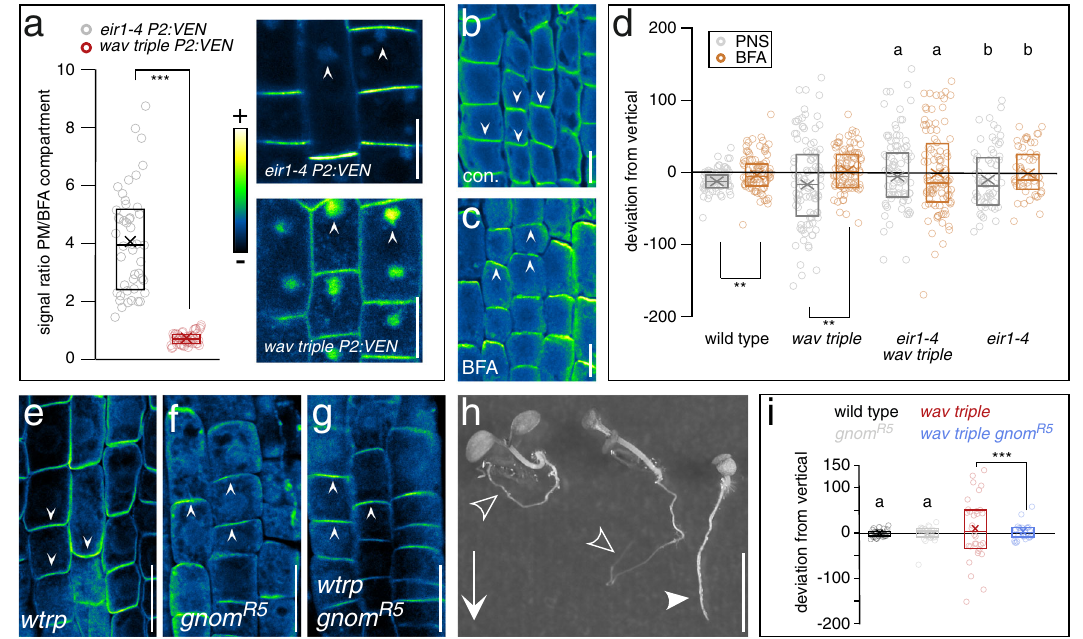
Fig. 6 | Wav triple -induced PIN2 polarity switches are mediated by BFA- sensitive cargo sorting. a PIN2::PIN2:VEN reporter signal distribution in root meristemepidermiscellsof6DAG eir1-4 ( n =47cells/7roots)and wavtriple ( n =46 cells/8roots)incubatedinpresenceof 50 μ MBFAfor90min.Arrowheadsindicate accumulation of reporter signals in BFA-induced intracellular compartments. b , c Subcellular PIN2 localization in wav triple root meristem epidermis cells in 6 DAG seedlings incubated on control plates ( ‘ con. ’ ; b ) or in presence of 50 μ M BFA ( ‘ BFA ’ ; c ) for 16h. Arrowheads indicate PIN2 polarity. d Orientation of root tips, expressed as degrees deviation from vertical of 6 DAG seedlings germinated on nutrient plates and then transferred on control nutrient plates ( n =81, wild type; n =99, wavtriple ; n =77, eir1-4wavtriple ; n =60, eir1-4 )oronplatessupplemented with10 μ MBFA( n =85,wildtype; n =96, wavtriple ; n =101, eir1-4wavtriple ; n =54, eir1-4 )for36h.SubcellularlocalizationofPIN2inrootmeristemepidermiscellsof6